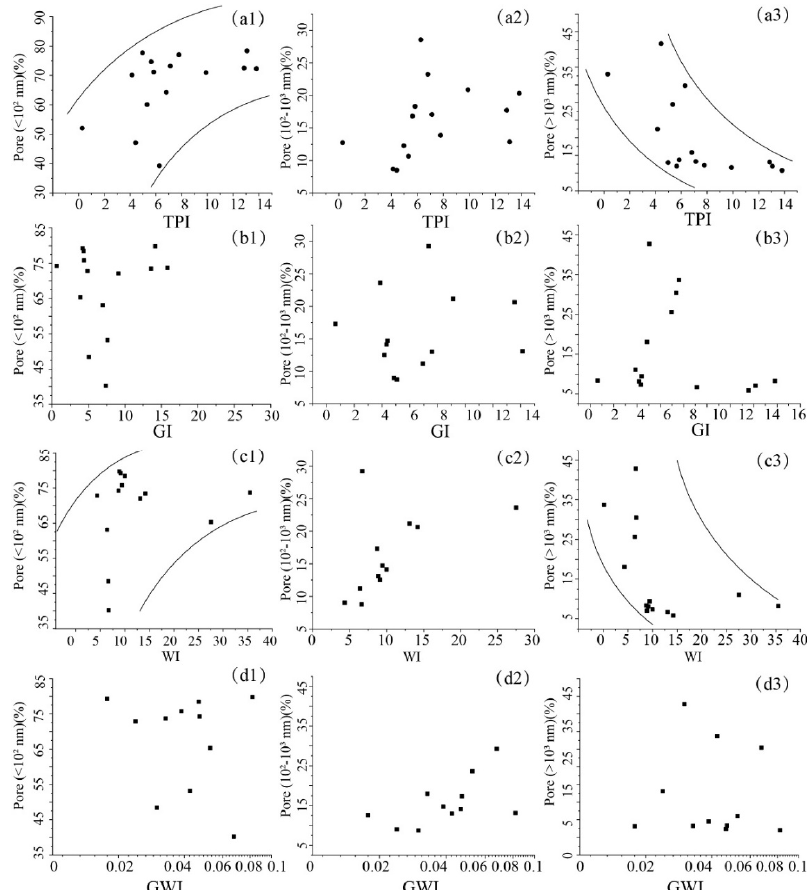
Figure 9. Relationships between the pore size and coal facies index. ( a1 ) the relationship between pore size ( < 10 2 nm) and TPI; ( a2 ) the relationship between pore size (10 2 nm–10 3 nm) and TPI; ( a3 ) the relationship between pore size ( > 10 3 nm) and TPI; ( b1 ) the relationship between pore size ( < 10 2 nm) and GI; ( b2 ) the relationship between pore size (10 2 nm–10 3 nm) and GI; ( b3 ) the relationship between pore size ( > 10 3 nm) and GI; ( c1 ) the relationship between pore size ( < 10 2 nm) and WI; ( c2 ) the relationship between pore size (10 2 nm–10 3 nm) and WI; ( c3 ) the relationship between pore size ( > 10 3 nm) and WI; ( d1 ) the relationship between pore size ( < 10 2 nm) and GWI; ( d2 ) the relationship between pore size (10 2 nm–10 3 nm) and GWI; ( d3 ) the relationship between pore size ( > 10 3 nm) and